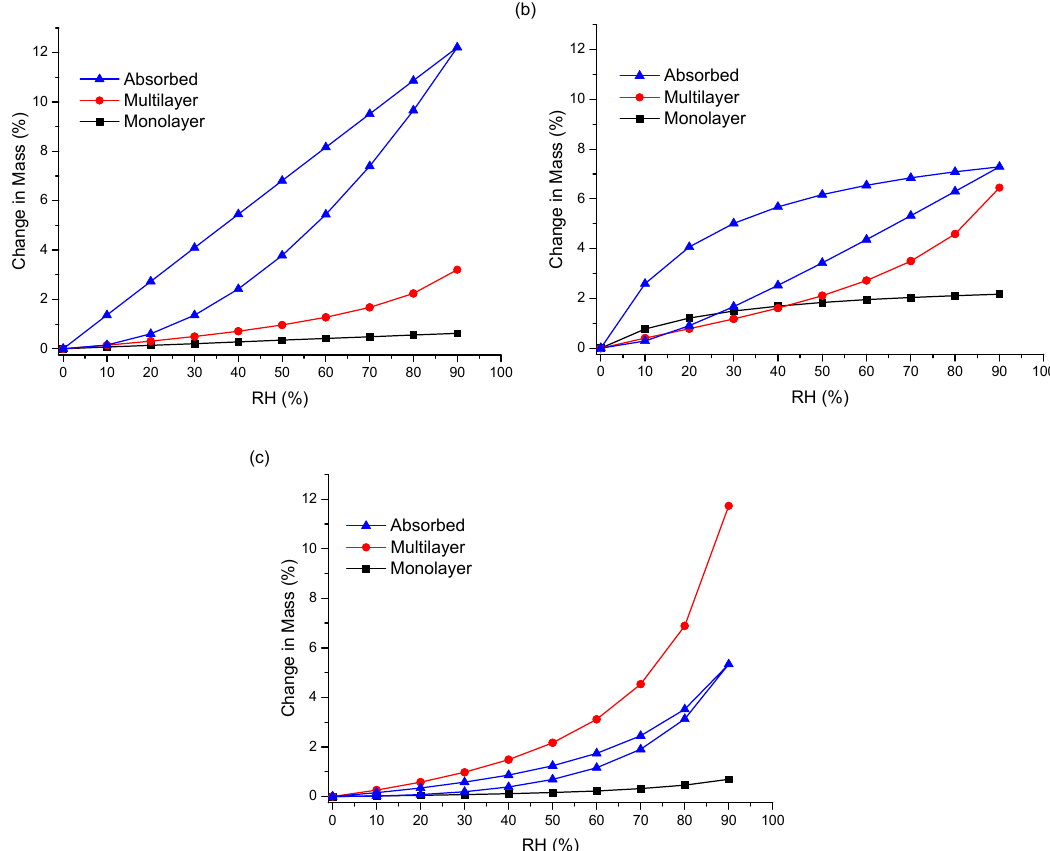
Figure 7. Water distribution patterns according to the Young–Nelson model in ENRO ASDs containing ( a ) Eudragit L100 40% ( w/w ), ( b ) Carbopol 40% ( w/w ), and ( c ) HPMCAS-LG 60% ( w/w ).